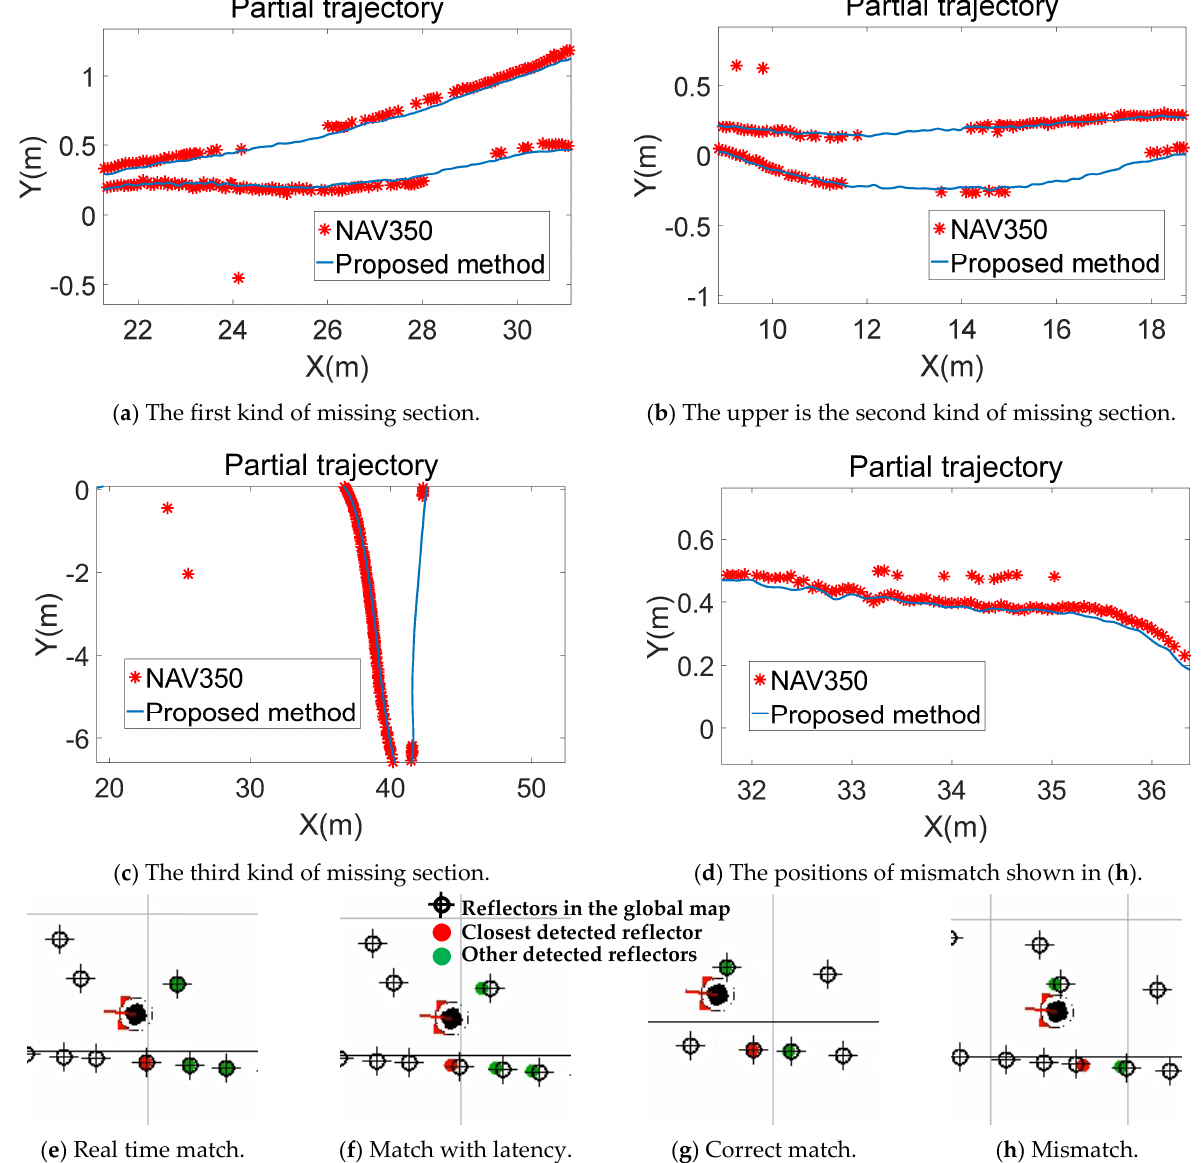
Figure 21. Analysis of missing sections of the NAV350 trajectory. There are three types of missing sections. The first type is the missing sections in ( a ) and lower missing section in ( b ). The cause of this type is latency in ( e , f ). The second type is the upper missing section in ( b ) which is caused by mismatch in ( g , h ). Positions calculated by mismatching are in ( d ). ( c ) is the third one caused by insufficient reflectors.